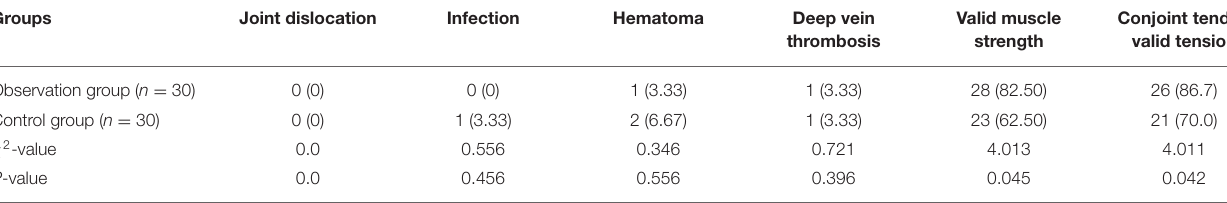
TABLE 3 | Valid muscle strength, conjoint tendon valid tension, and post-operative complications.